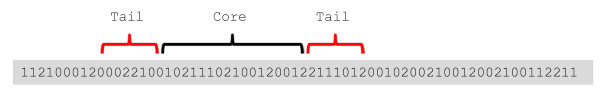
A core and its adjacent tails.